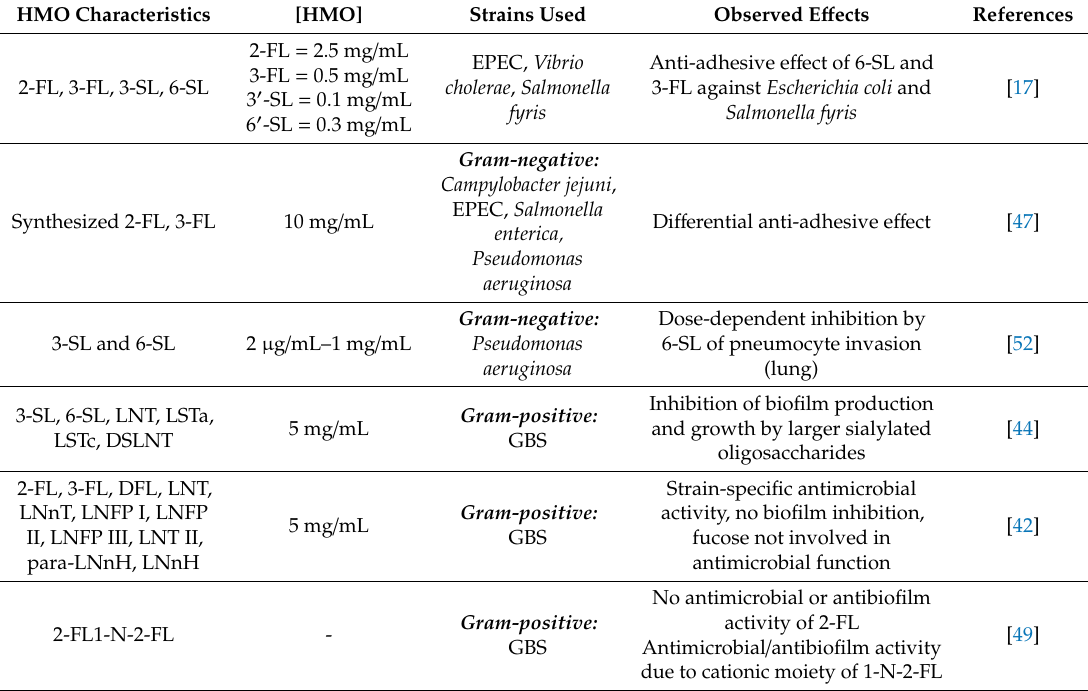
Table 2. Overview of the anti-pathogenic functionalities of isolated